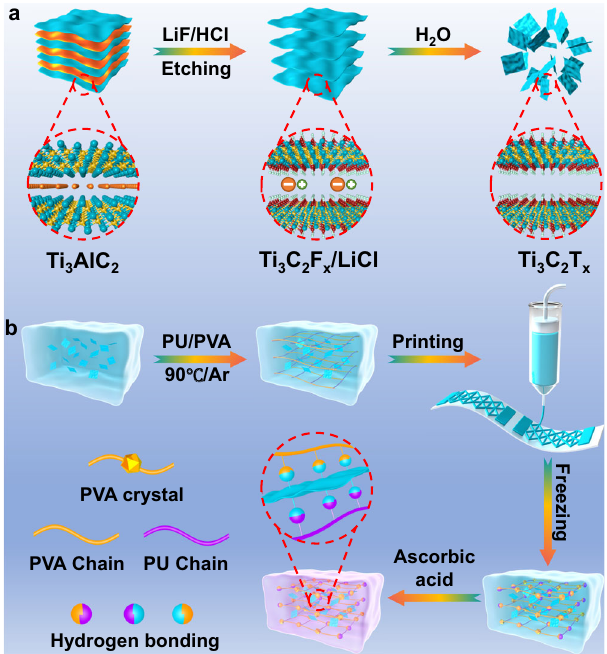
Fig. 1 Synthesis of MXenes and hydrogel. a Schematic illustration for the preparation of Ti 3 C 2 T x fl akes. b Direct ink writing (DIW) printing of transition metal carbides (MXenes) bonded polyurethane/polyvinyl alcohol (PU/PVA)